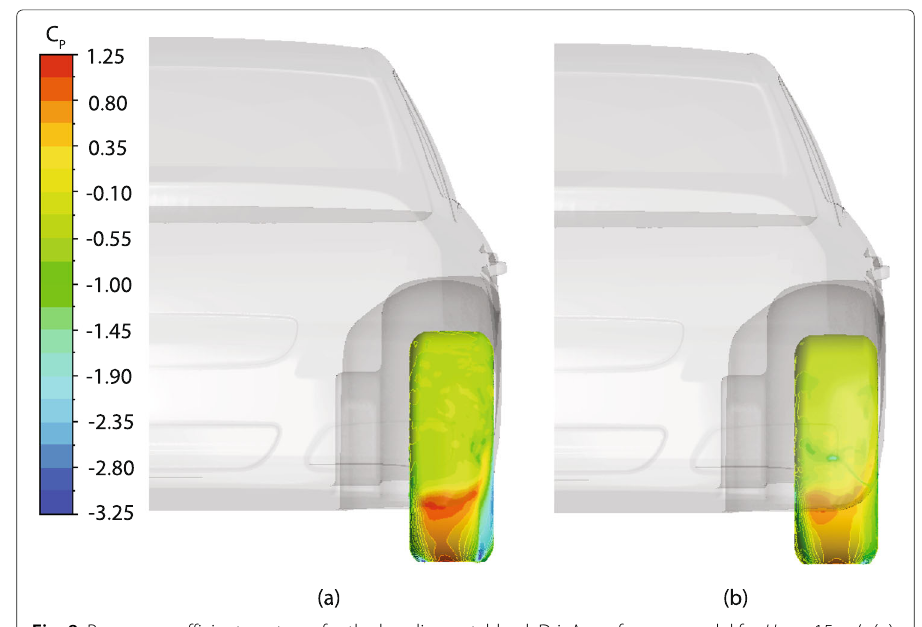
Fig. 8 Pressure coefficient contours for the baseline notchback DrivAer reference model for U ∞ = 15 m/s ( a ) front wheel and ( b ) rear